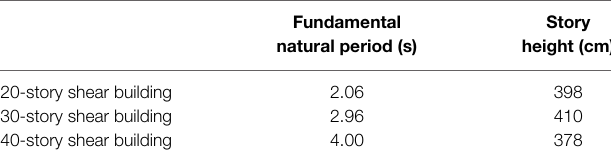
TABLE 2 | Fundamental natural period and story height of 20-, 30-, and 40-story shear buildings